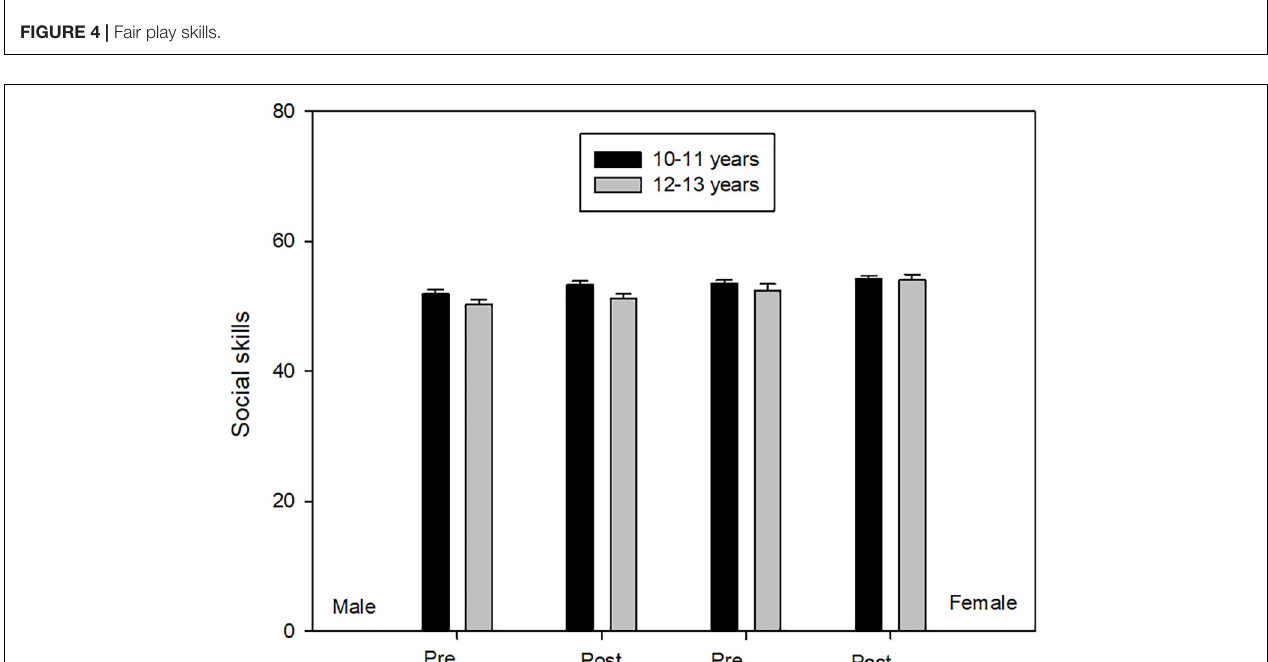
FIGURE 4 | Fair play skills.